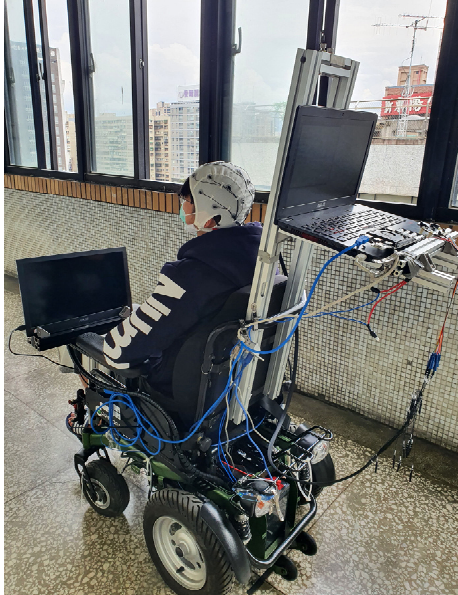
Figure 5. The electric wheelchair for this study.